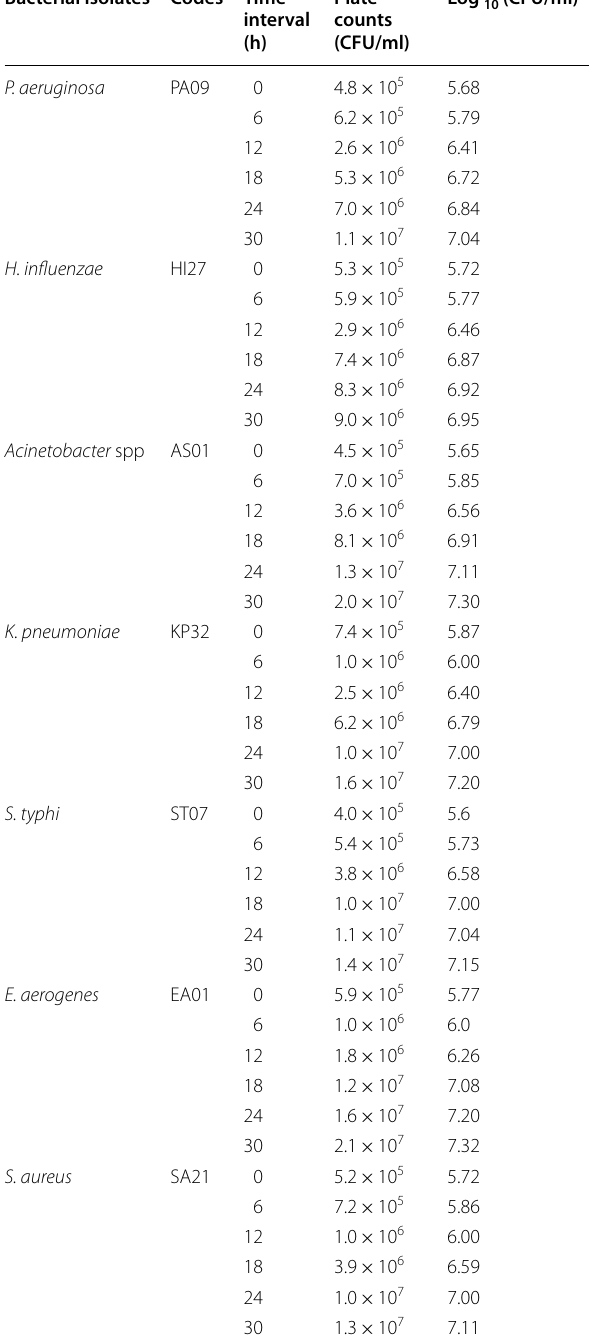
Table 5 Growth of bacterial cells unexposed to fluoroquinolone antibiotics Bacterial isolates Codes Time